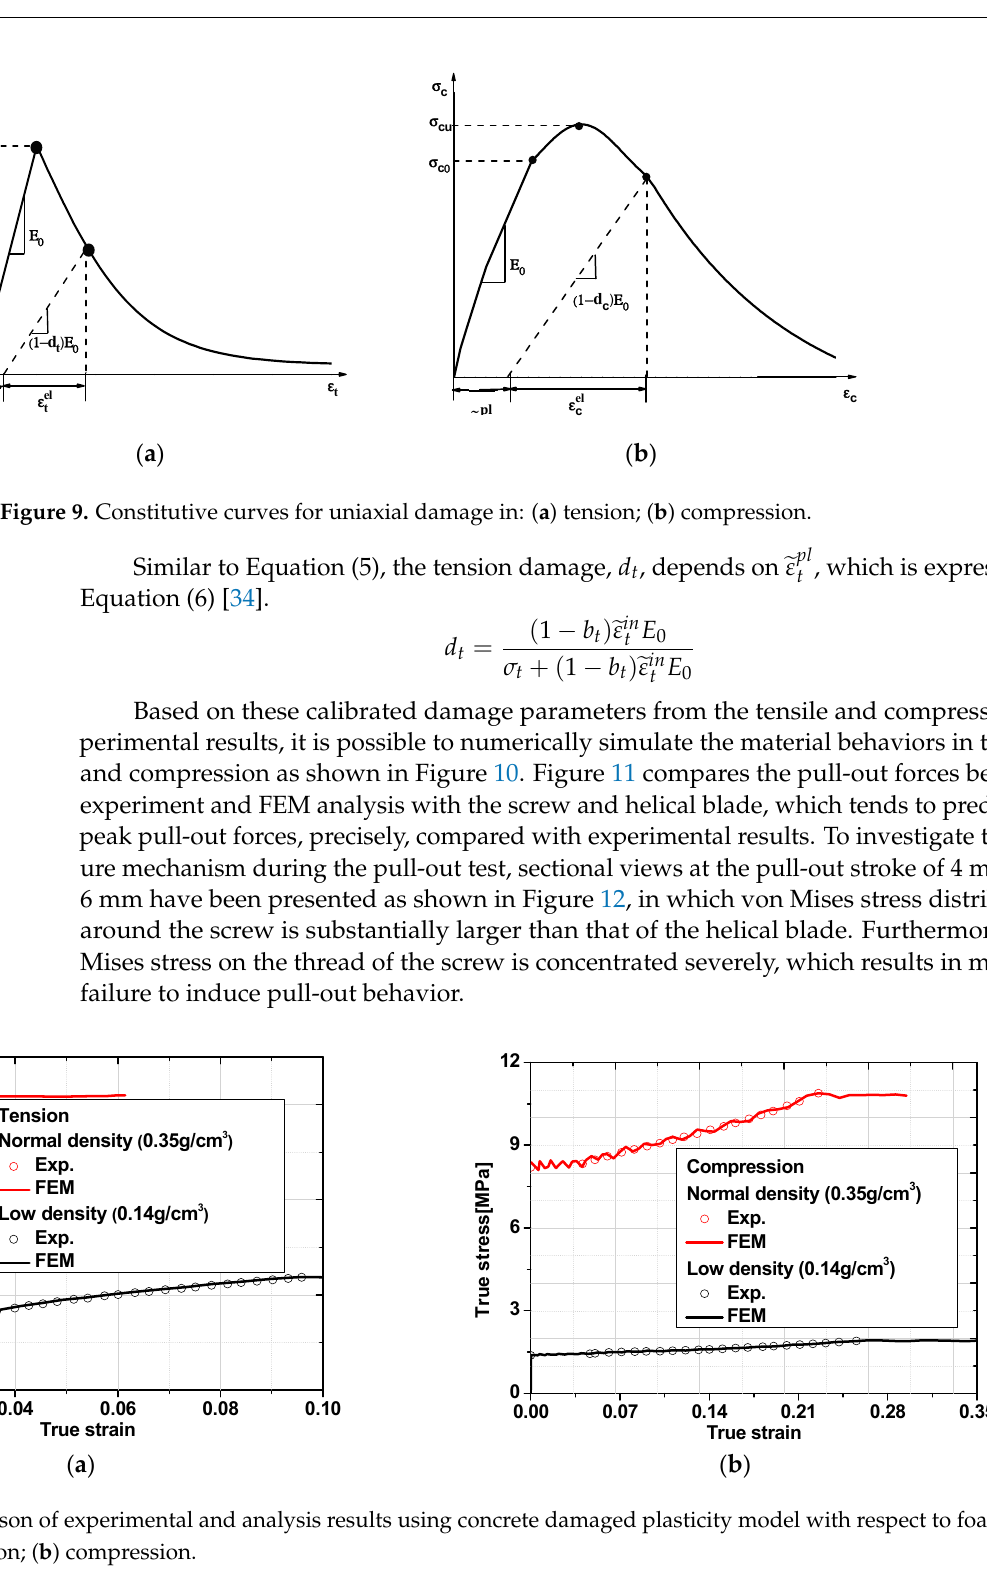
Figure 8. Initial modeling for FEM analysis: ( a ) screw; ( b ) helical blade.